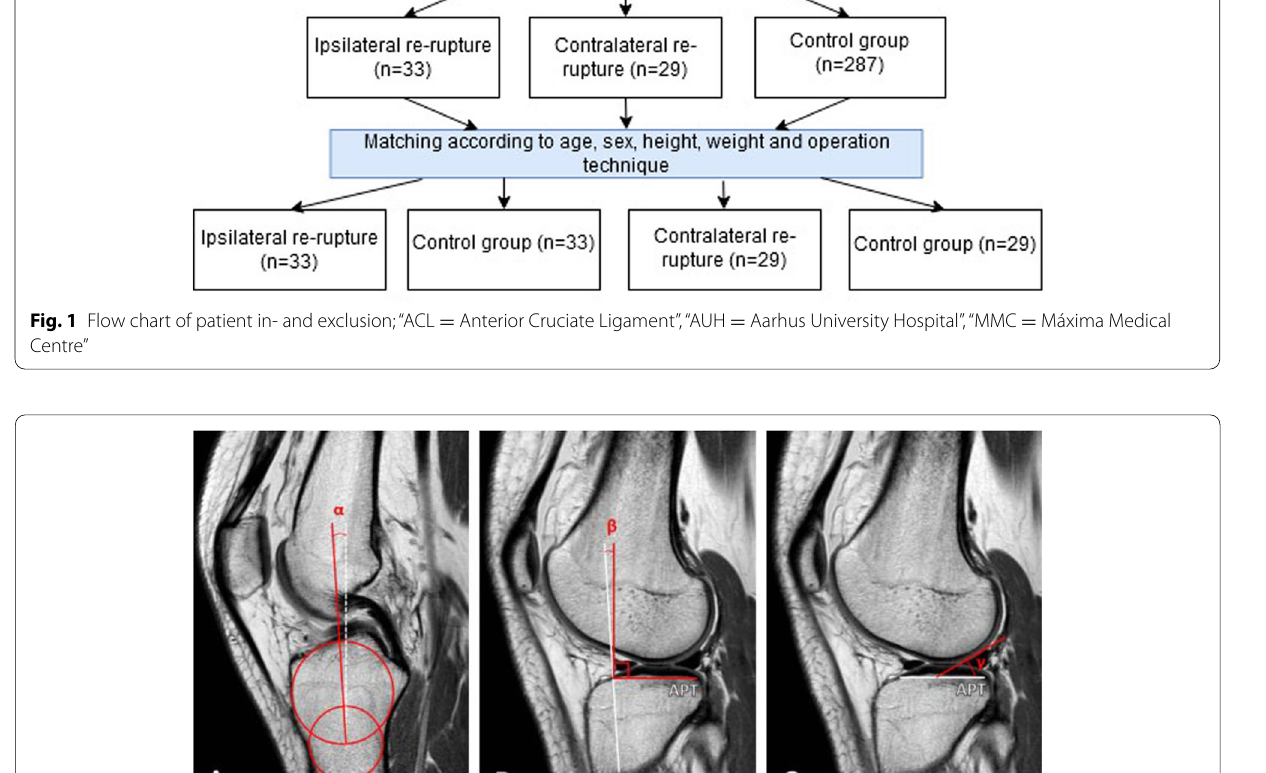
Fig. 2 MRI measurements of the tibia. A The longitudinal tibial axis (α) is drawn. B After drawing the AP depth of the tibial plateau [APT], α is used to determine the tibial slope (β). C The meniscal bone angle (γ) is drawn using the